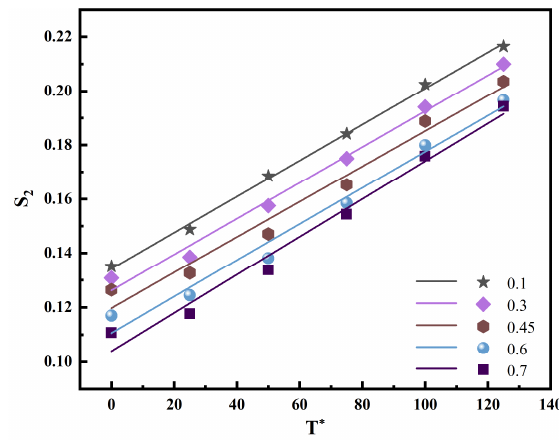
Figure 12. Plot of T* ‐ S 2. This led to the MZA constitutive model for the